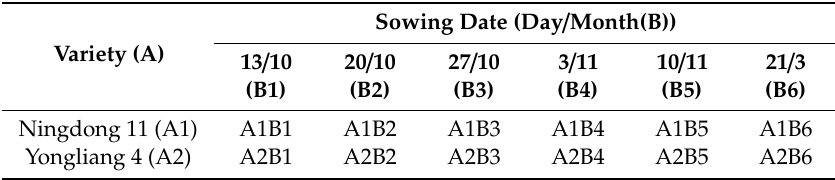
Table 3. Experimental design scheme for